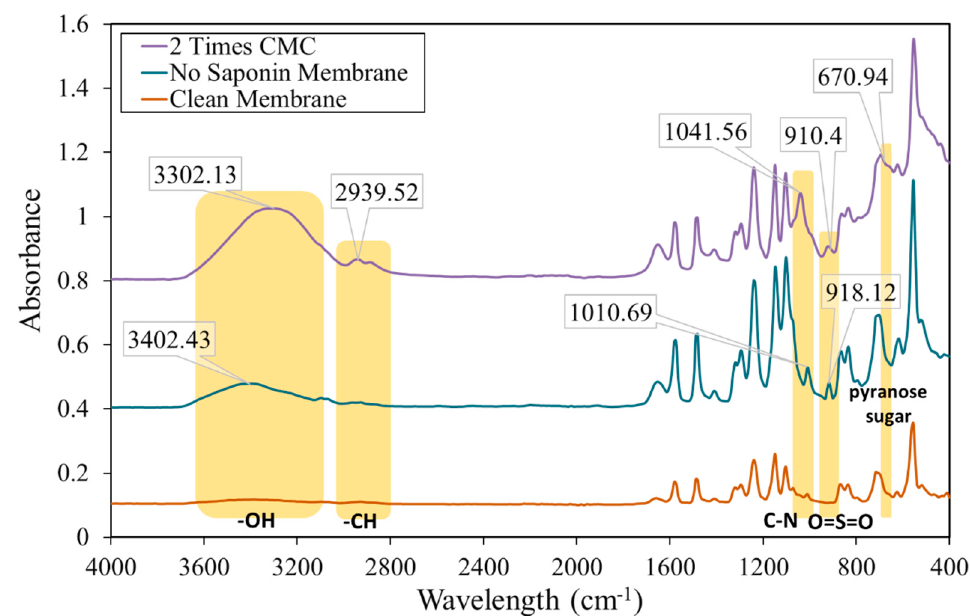
Figure 7. FTIR Spectra of clean polyethersulfone (PES) and fouled membranes.